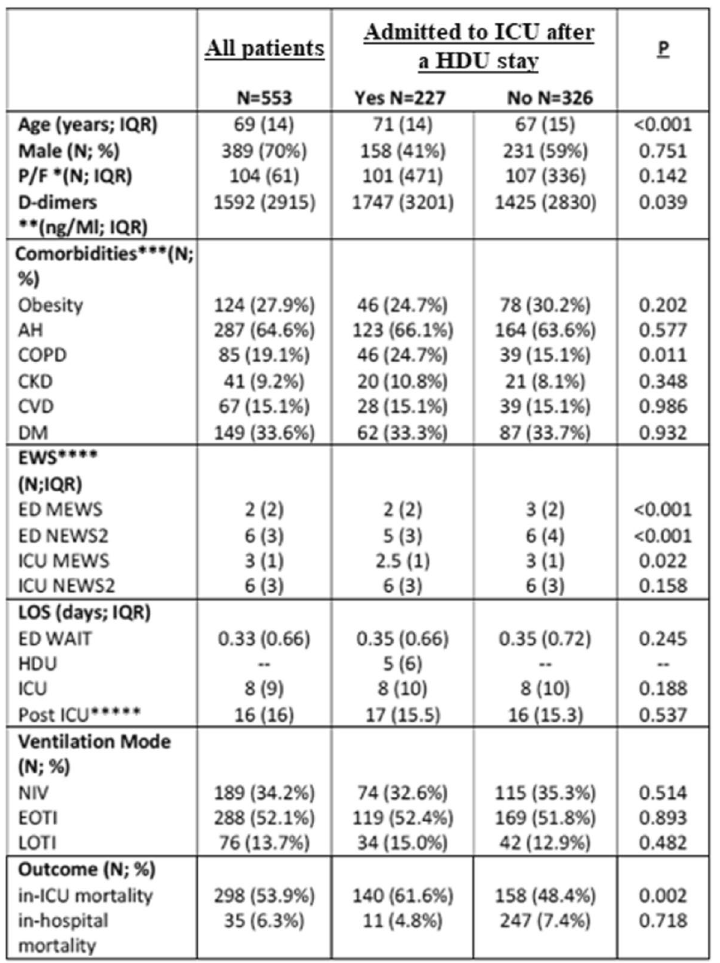
Table 1 Data are presented as median (IQR) or number